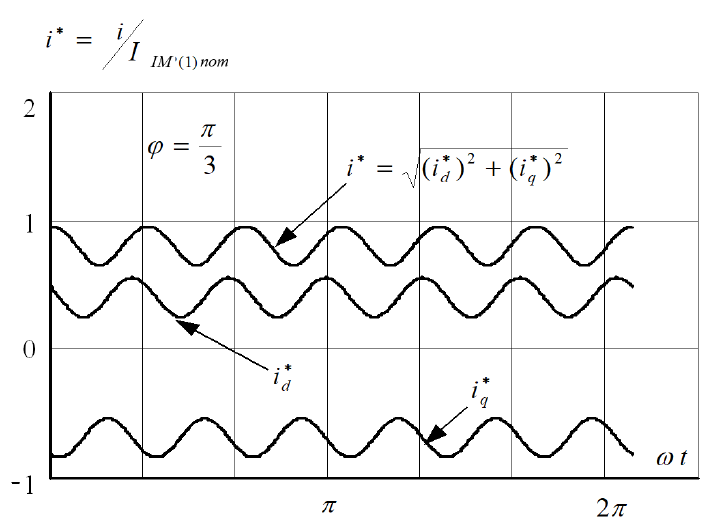
Figure 6. The shape of the assignment total signals along the orthogonal